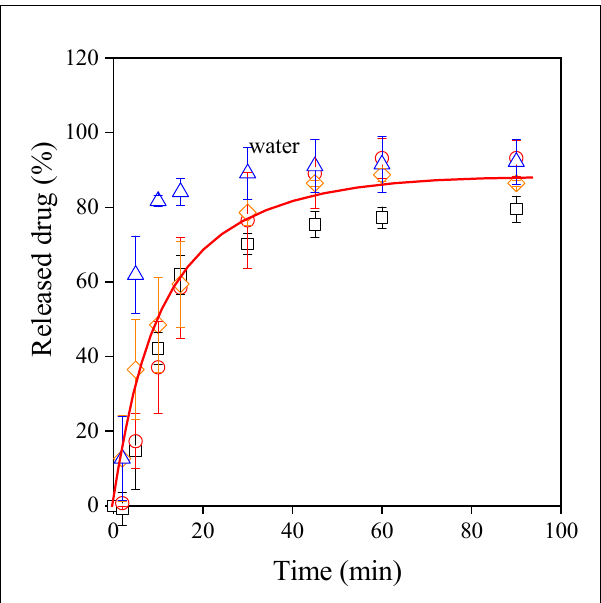
Figure 9. The kinetics of drug release from electrospun fibers prepared from PVA. Symbols: ( ) pH 1.2, ( ) pH 4.0, ( ) pH 6.8, ( ) water.